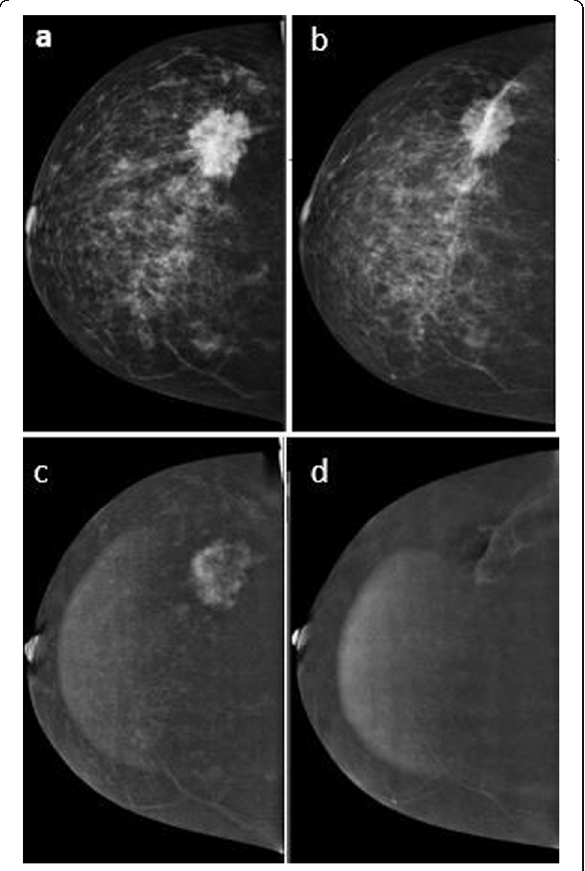
Fig. 3 a Pre-NAC mammogram; spiculated UOQ mass. b Post-NAC mammogram; reduction in the size of the mass. c Pre-NAC CESM; an enhancing mass. d Post-NAC CESM; type I shrinkage. RECIST 1.1; non-responder. Combined response evaluation; partial responder. Pathology; Miller-Payne grade